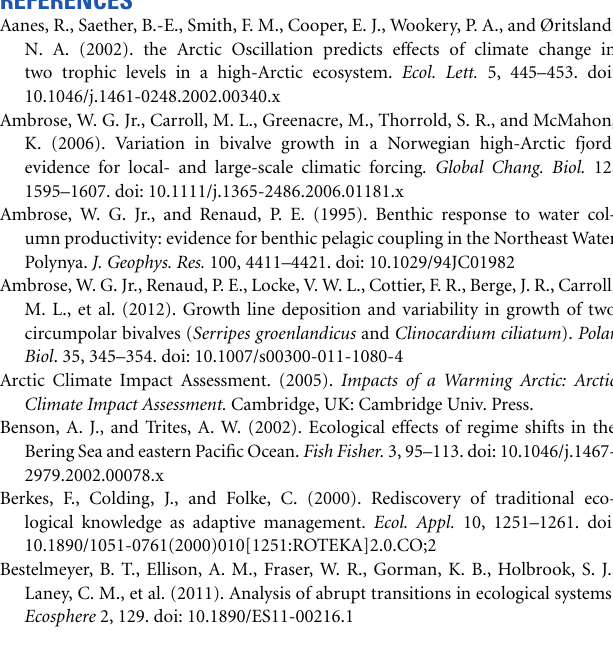
Figure 1 . Comments from R. Bernard, E. Jones, J. Muratori,